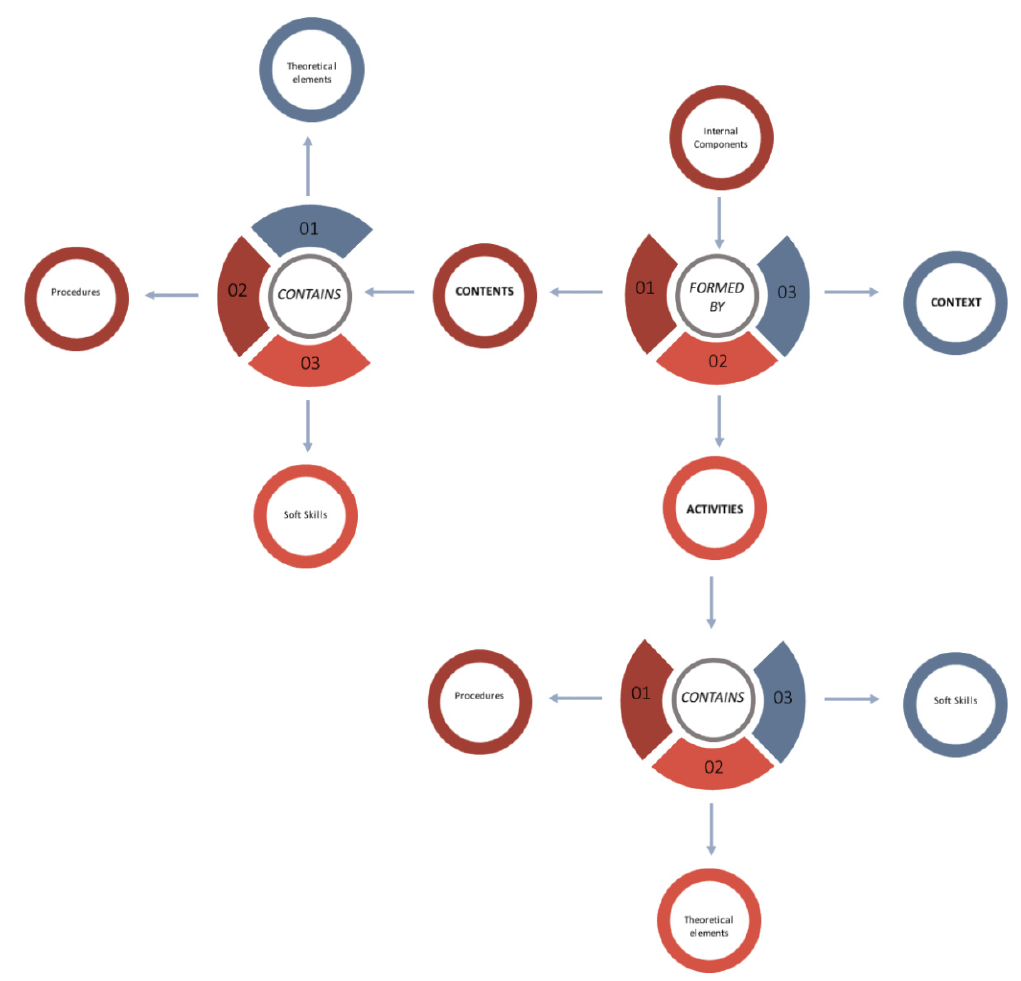
Figure 5. Taxonomy of learning objects. Internal components . Source: based on Cuervo (2011); Castrillón (2011); Sánchez Medina (2014).